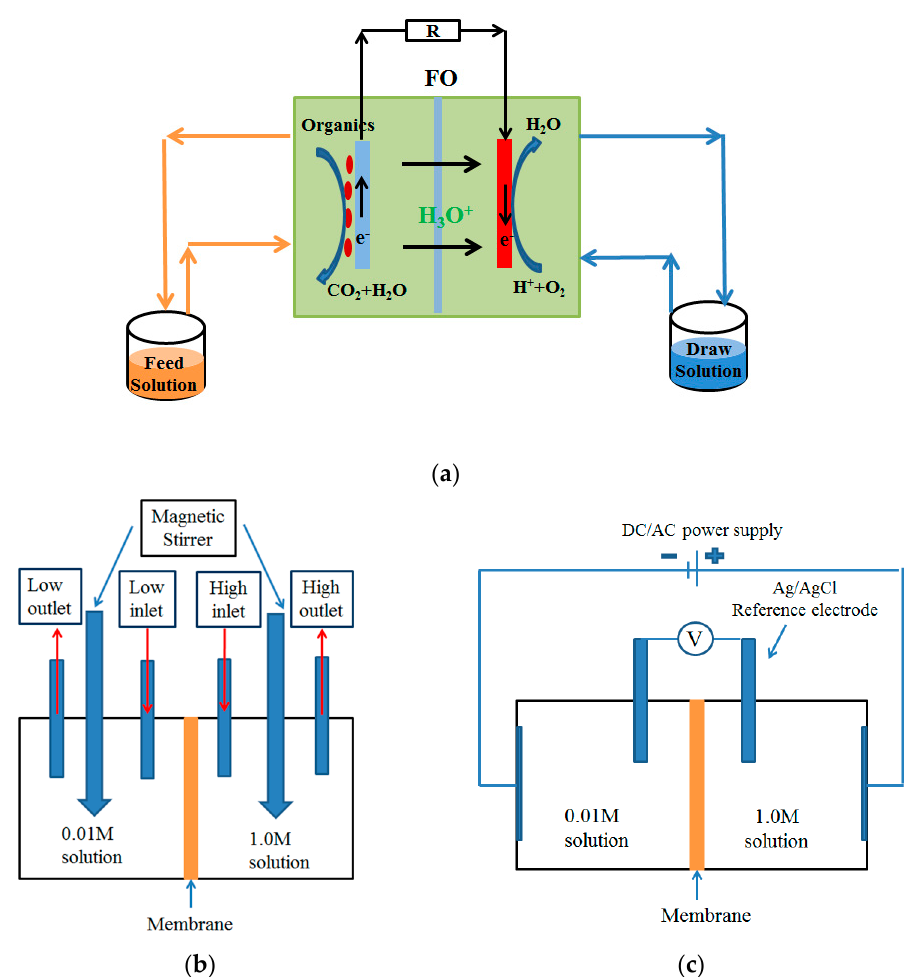
Figure 2. ( a ) Schematic of the forward osmosis microbial fuel cell (OsMFC). ( b ) Pretreatment device for measuring membrane resistance under the concentration gradient. ( c ) Membrane impedance measuring device with different concentrations on both sides of the membrane.